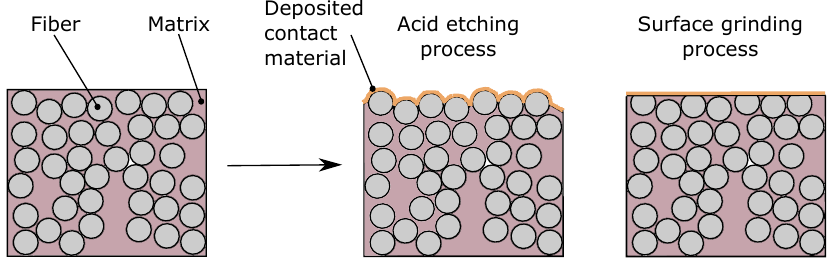
Figure 3. Schematic idea of the difference between mechanical sanding and acid etching surface treatments.